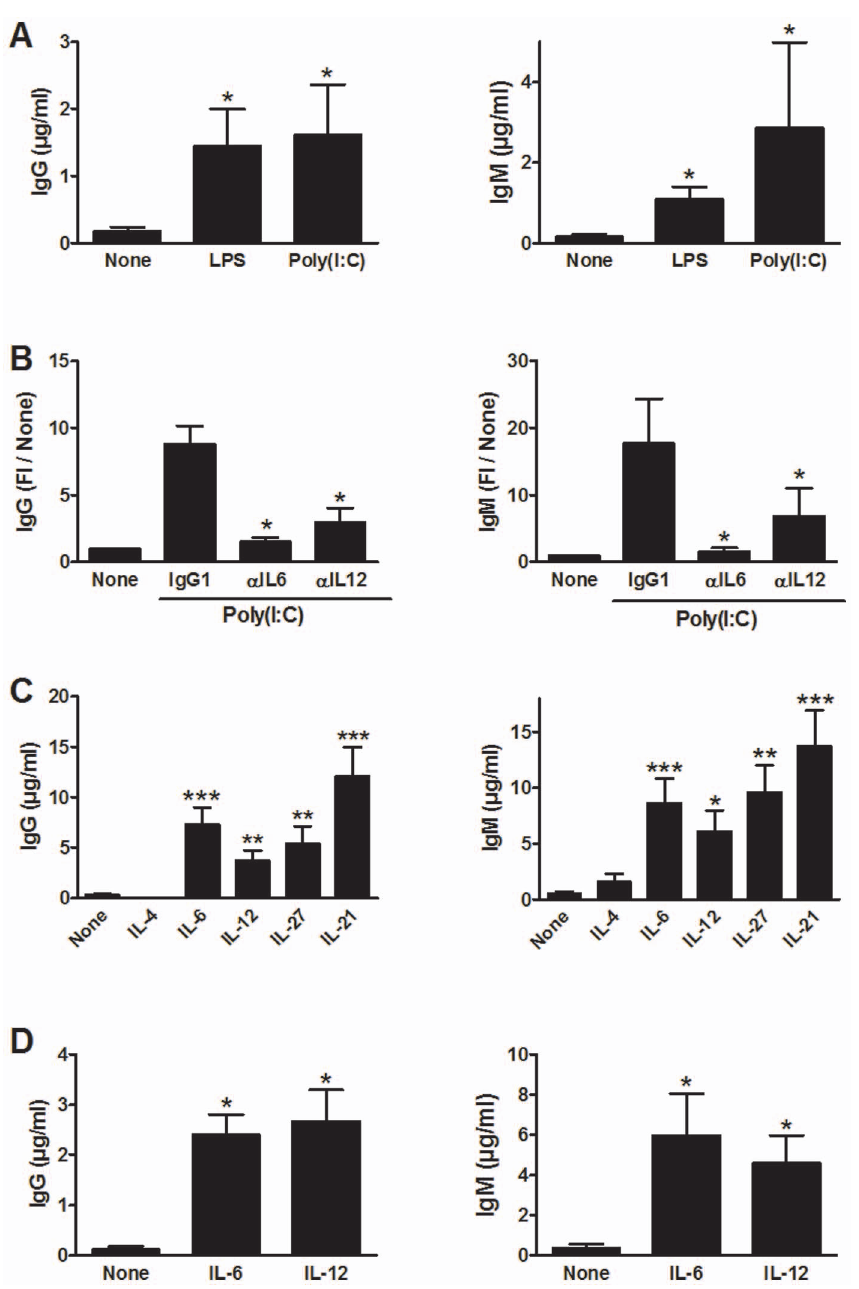
Figure 1. IL-6, IL-12 and IL-27 promote the differentiation of CD4 T cells helping B cells. A) Naive cord blood CD4 T cells were primed with plate bound anti-CD3 (5 m g/ml) and soluble anti-CD28 (1 m g/ml) mAbs during 72 hours in the presence of supernatant from immature moDCs activated with LPS, Poly(I:C) or incubated with medium alone. T cells were then thoroughly washed before T/B co-culture to avoid potential carry-over effect of the DC supernatants and were incubated with anti-CD3 mAb and heterologous B cells before measuring Ig production. B) Experiments were performed as in (A) except that anti-IL-6, anti-IL-12 or control mAbs (10 m g/ml) were added to DC culture supernatants before CD4 T cell priming. C) Experiments were performed as in (A) except that recombinant cytokines were used instead of DC culture supernatants. D) Experiments were performed as in (C) except that TSST was used in the T/B co-culture instead of anti-CD3 mAb. Data are mean 6 SEM of triplicates from one representation of 3 (A), of 4 (B) or 6 (C and D) independent experiments on different donors. FI/None: fold increase as compared to no cytokine. *p , 0.05, **p , 0.01 and ***p , 0.001 as determined by paired Wilcoxon signed-rank test (A, C and D) or paired Student’s t-test (B).